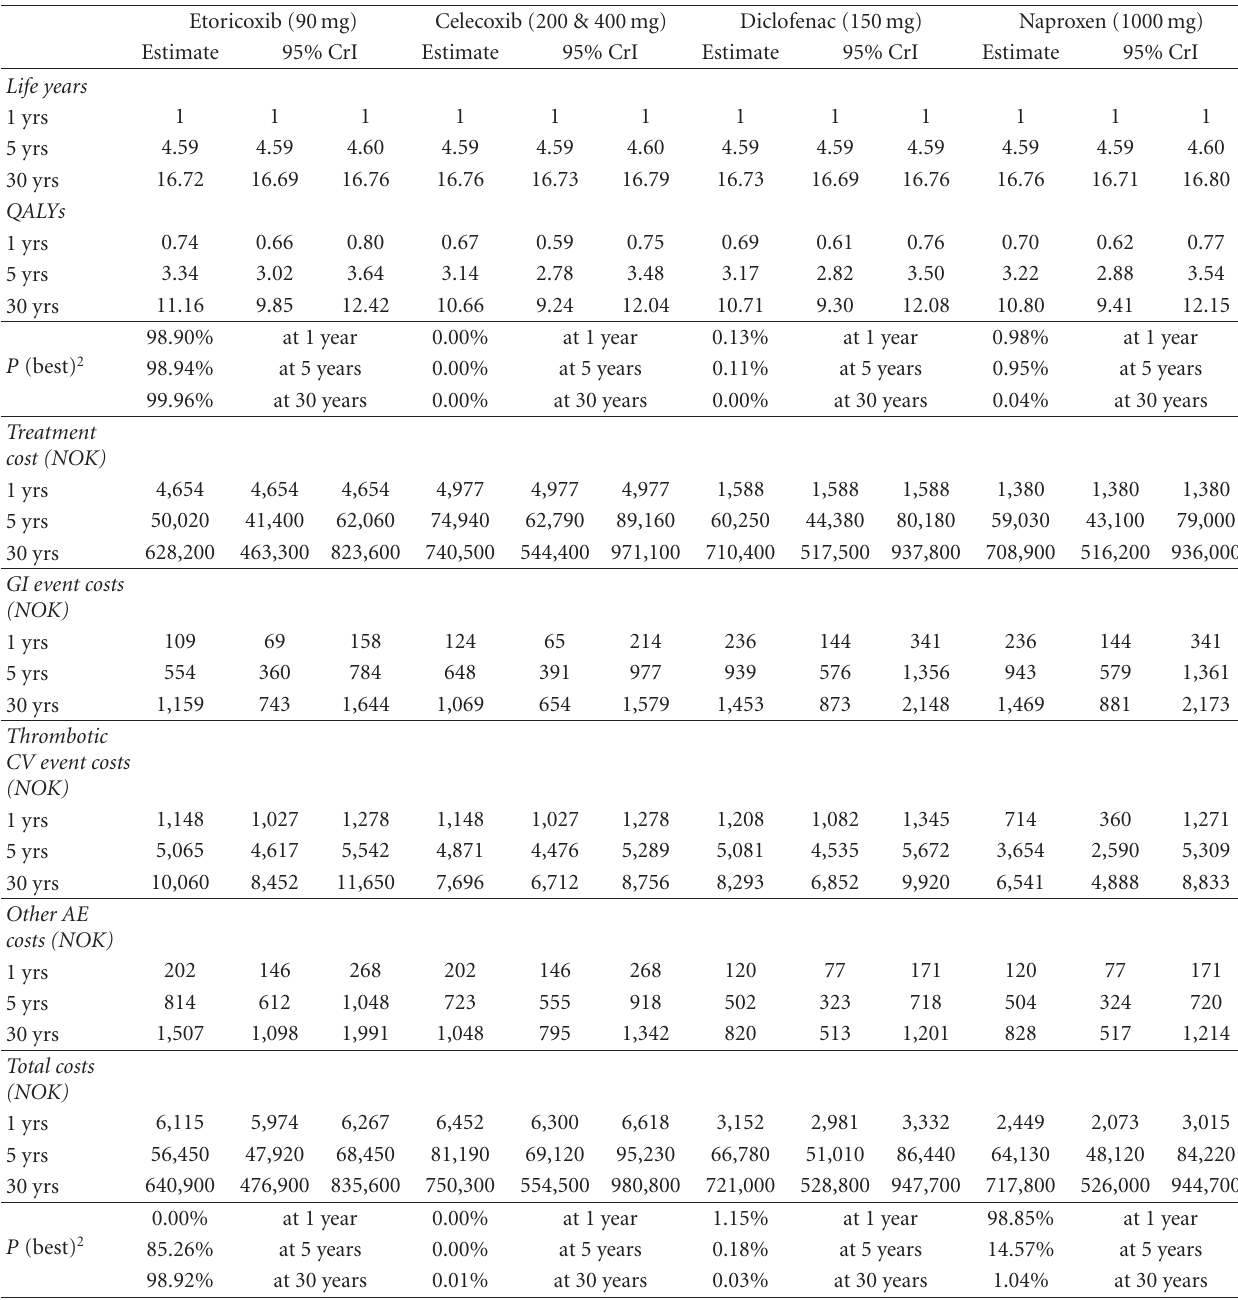
Table 4: Estimated e ff ects and costs by treatment (base-case